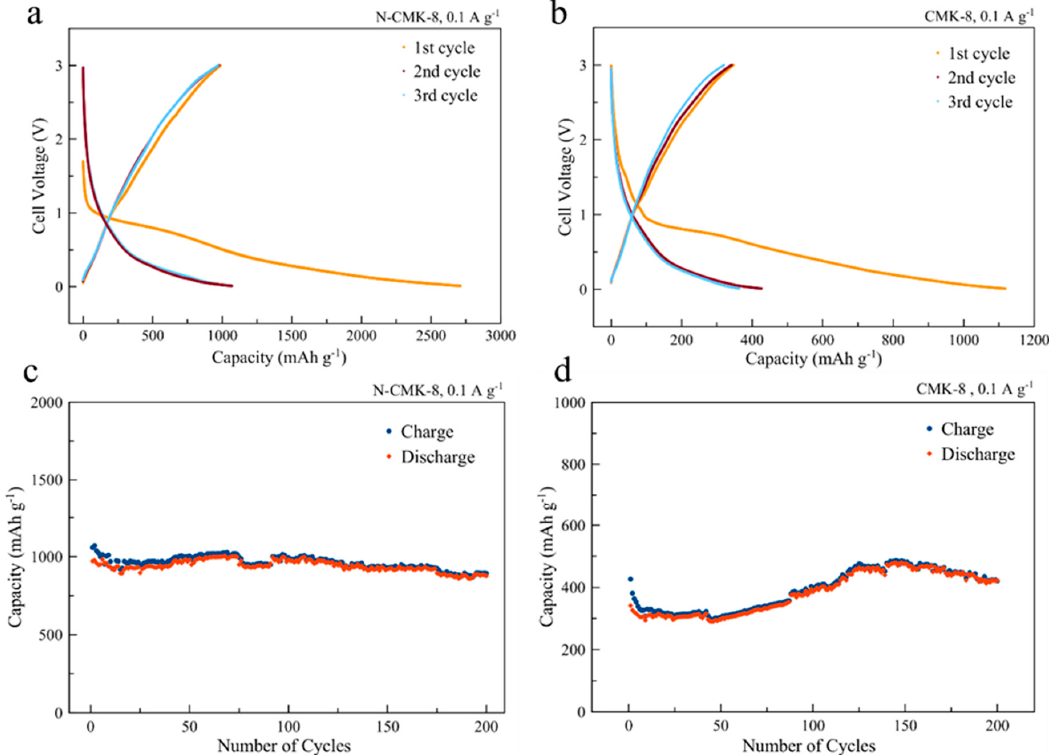
Figure 4. Voltage profiles for the first 3 cycles of ( a ) N-CMK-8 and ( b ) CMK-8. Long-term specific capacities of ( c ) N-CMK-8 and ( d )